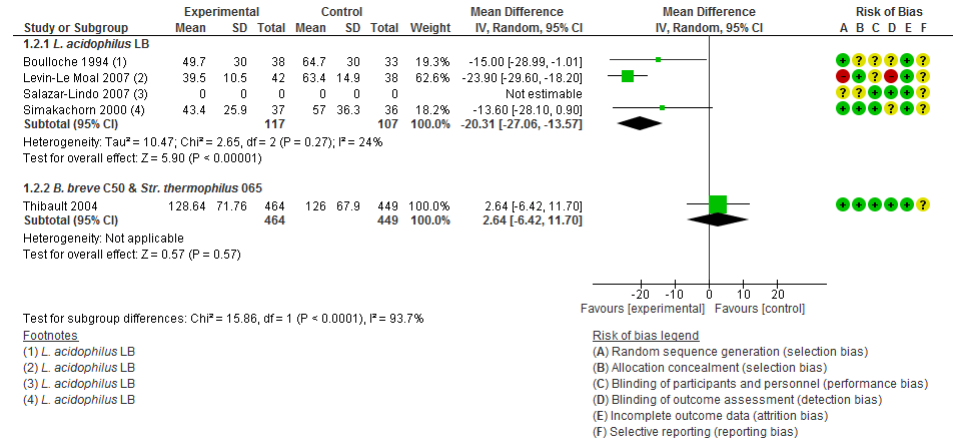
ff ect of postbiotic supplementation on the duration (hours) of acute Figure 3. Effect of postbiotic supplementation on the duration (hours) of acute diarrhoea. Figure 3. E